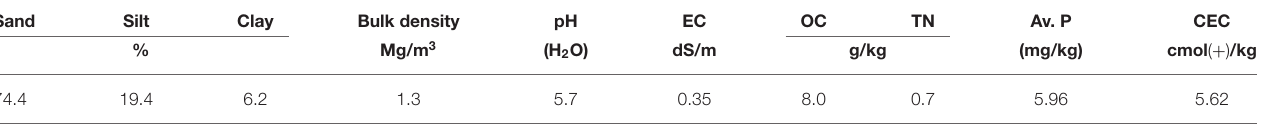
TABLE 1 | Some physicochemical properties of Toje Series*.